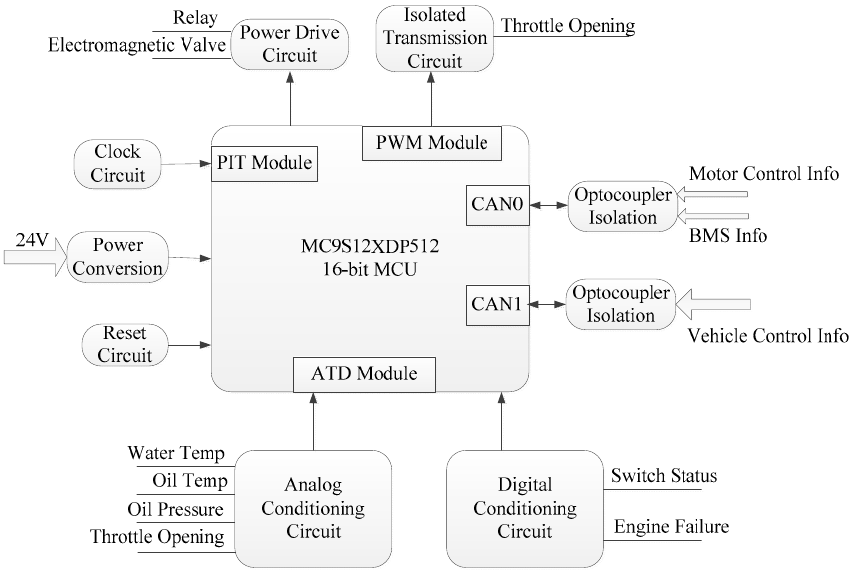
Figure 6. APU controller hardware schematic.